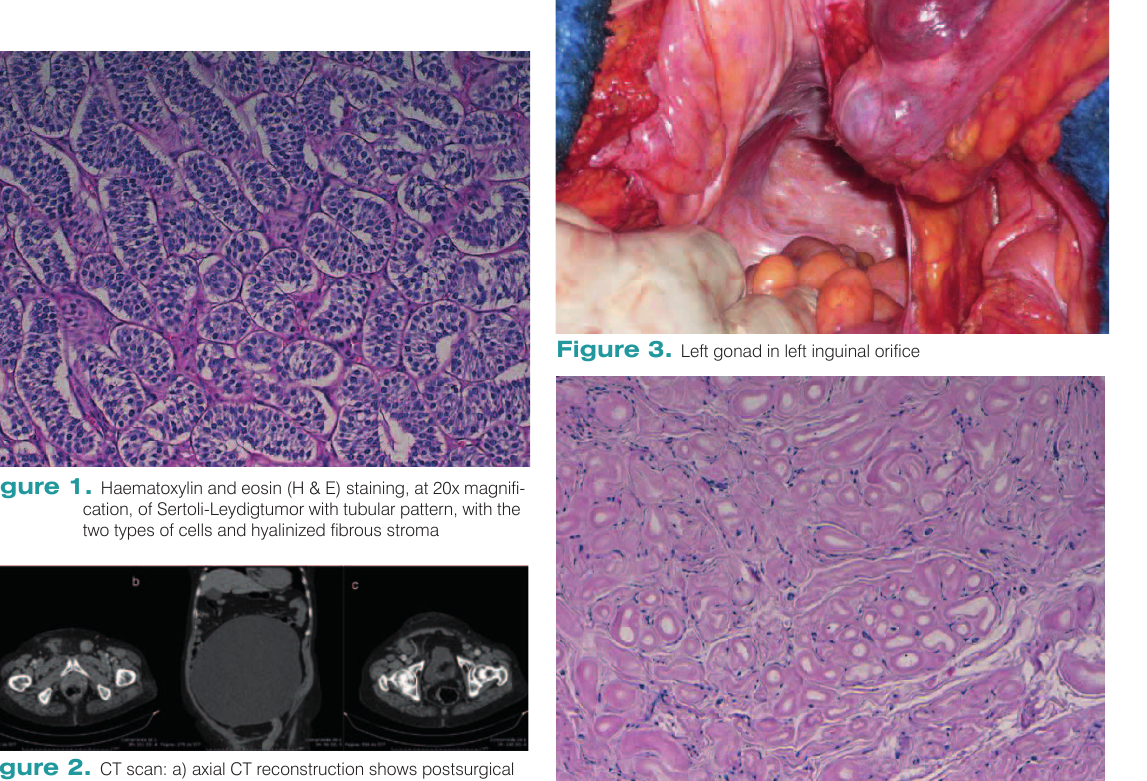
Figure 2. CT scan: a) axial CT reconstruction shows postsurgical changes in the right inguinal region and solid mass in the left inguinal region; b) coronal CT reconstruction shows cystic abdominal mass and left inguinal mass; c) axial CT